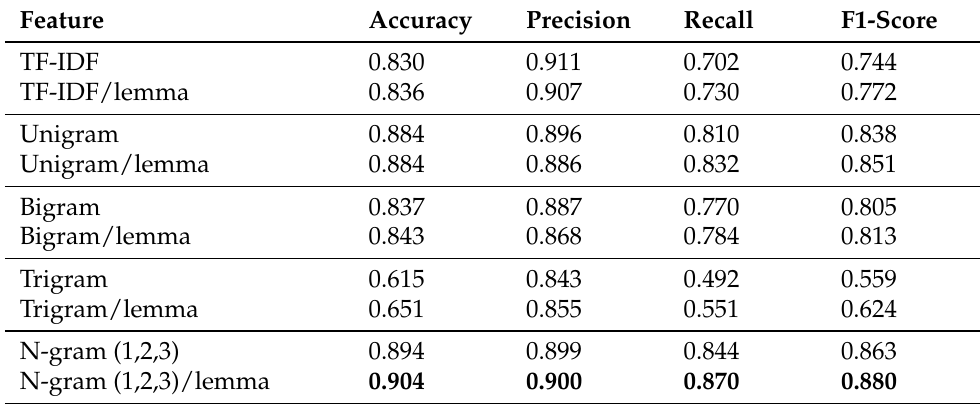
Table 7. Metrics with different combinations of